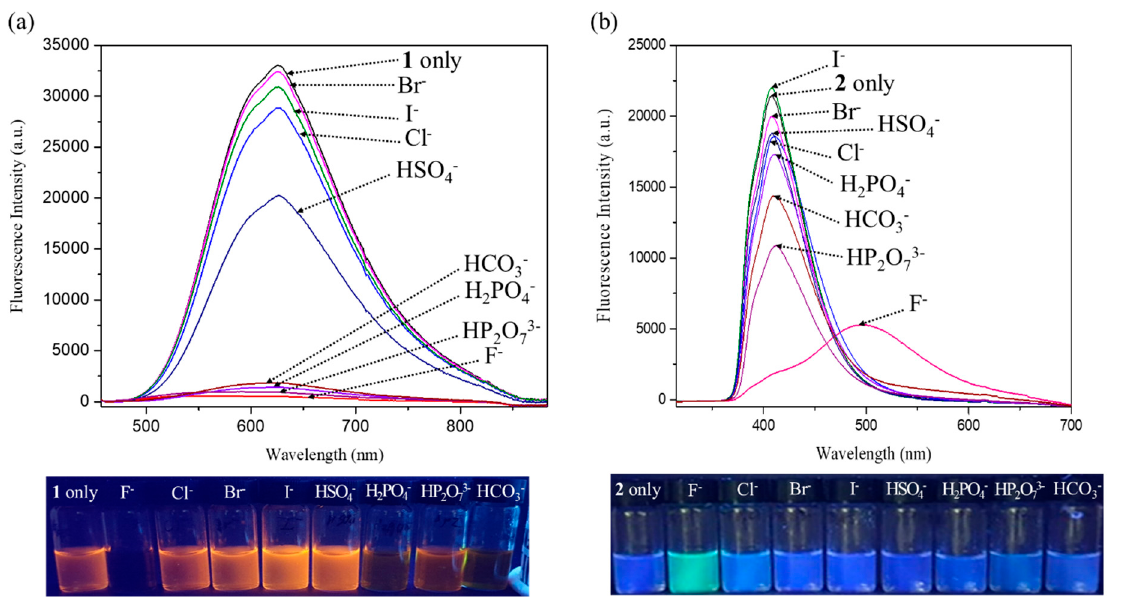
Figure 10. Top: Fluorescence spectra of receptors 1 ( a ) and 2 ( b ) in the absence and the presence of the indicated anions (as their respective TBA + salts for all anions but the bicarbonate anion which was used in its TEA + salt form) in CH 3 CN. Bottom: Photographs showing the corresponding fluorescence changes of the CH 3 CN solutions of receptors 1 ( a ) and 2 ( b ). Receptors 1 and 2 were excited at 448 nm and 307 nm, respectively.